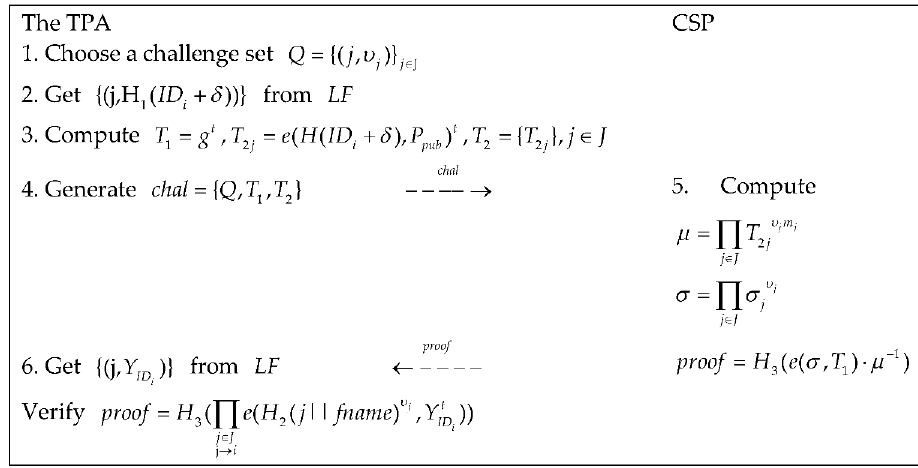
Figure 2. CL-PGSDP protocol.